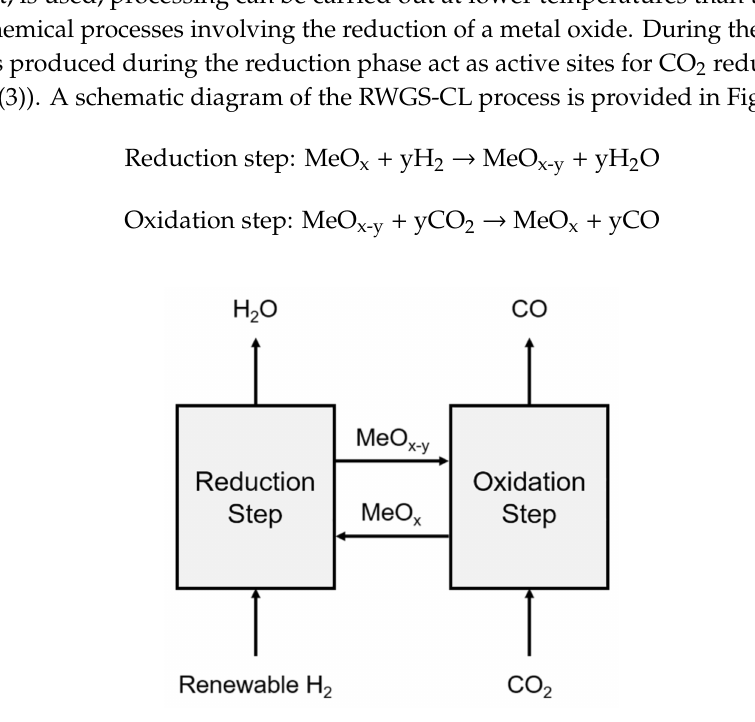
Figure 1. Schematic of the reverse water–gas shift chemical looping (RWGS-CL)